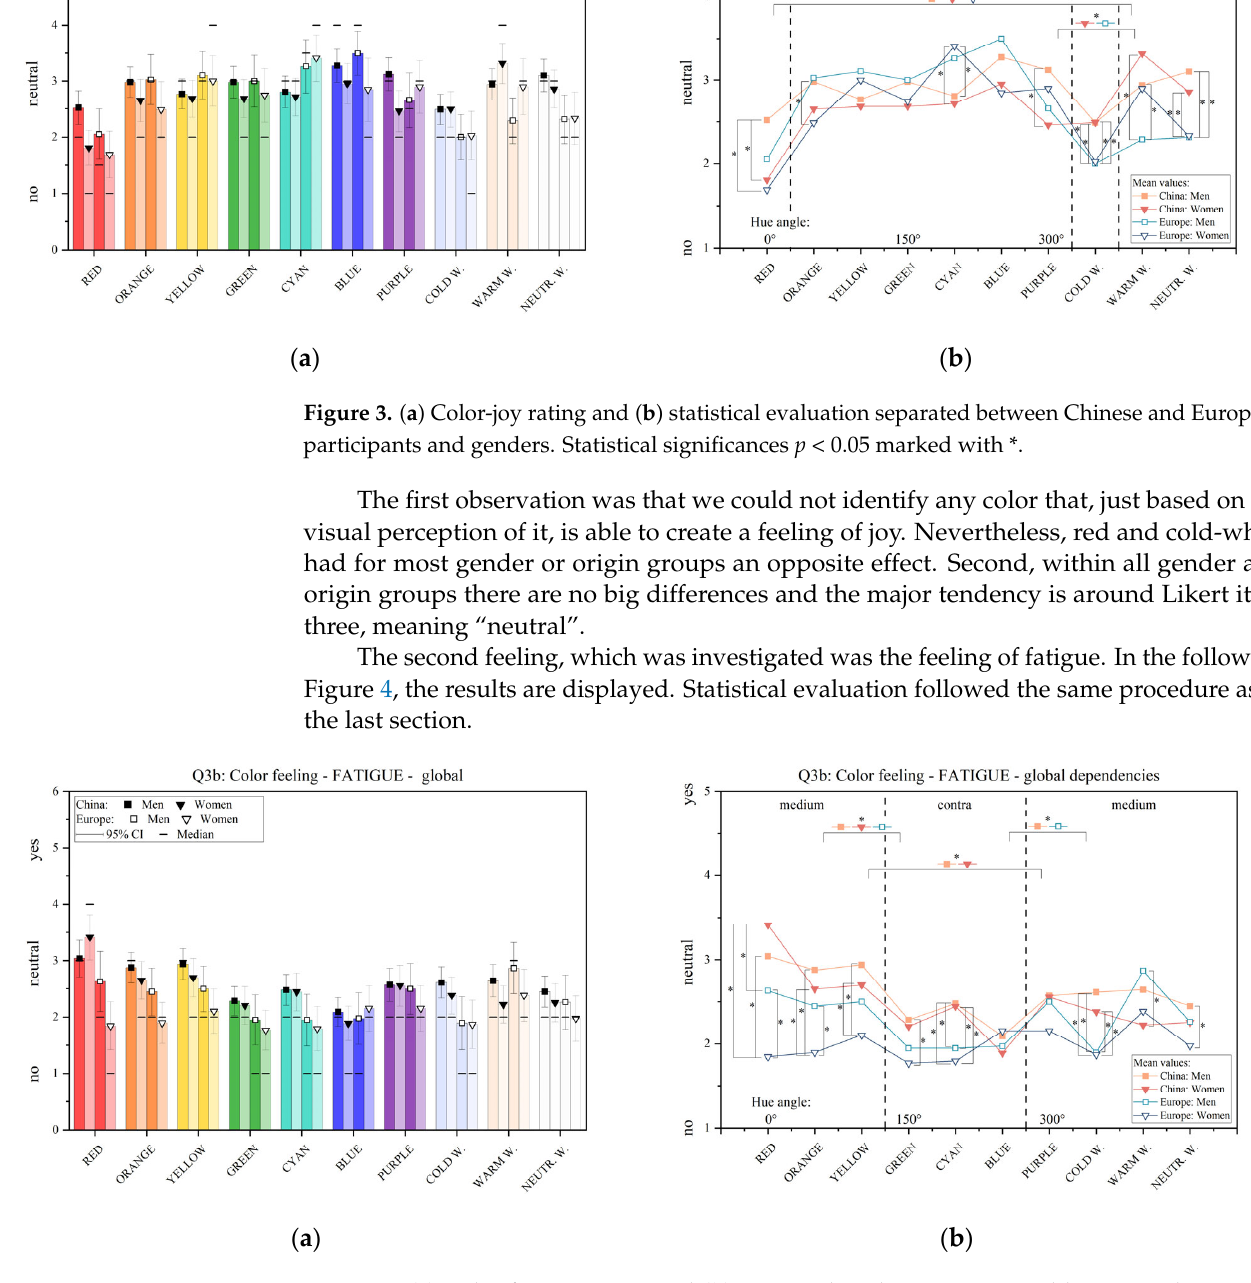
Figure 4. ( a ) Color ‐ fatigue rating and ( b ) statistical evaluation separated between Chinese and European participants and genders. Statistical significances p < 0.05 marked with *.